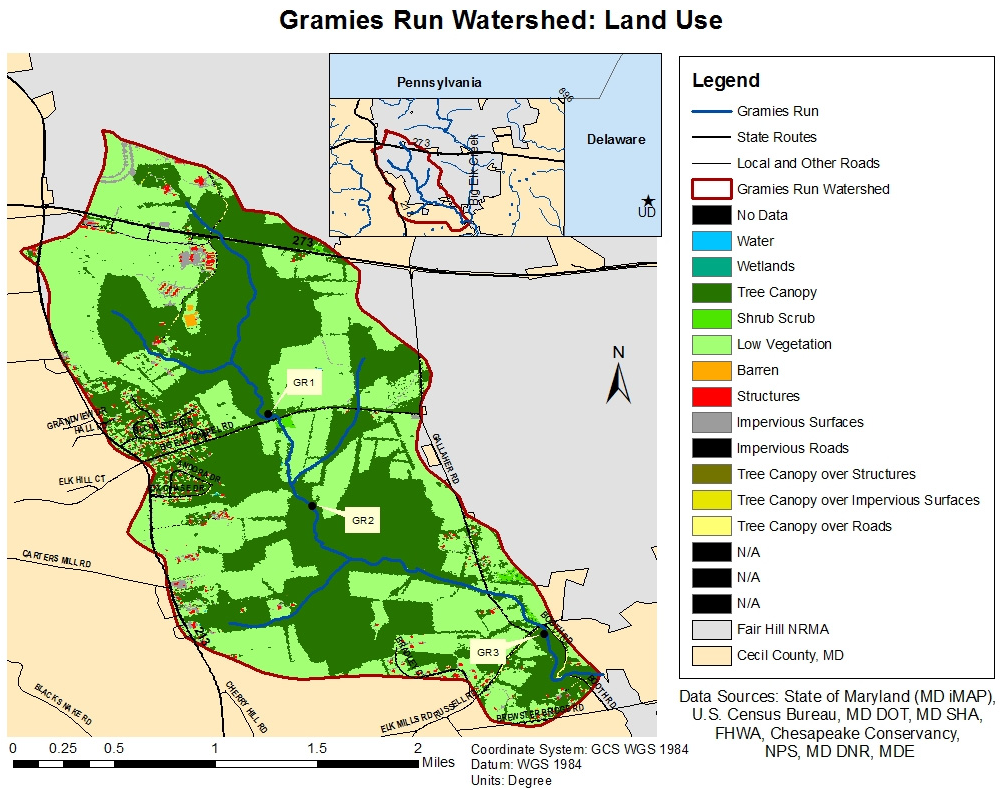
Figure 1. Location of Gramies Run watershed within the Big Elk Creek drainage basin (inset) and land use within the Gramies Run watershed (high resolution land cover data obtained from Chesapeake Conservancy’s Conservation Innovation Center). The grey shaded area (inset) represents state-owned (Maryland DNR) property. Location of the stream water sampling points GR1, GR2, and GR3 are also indicated.